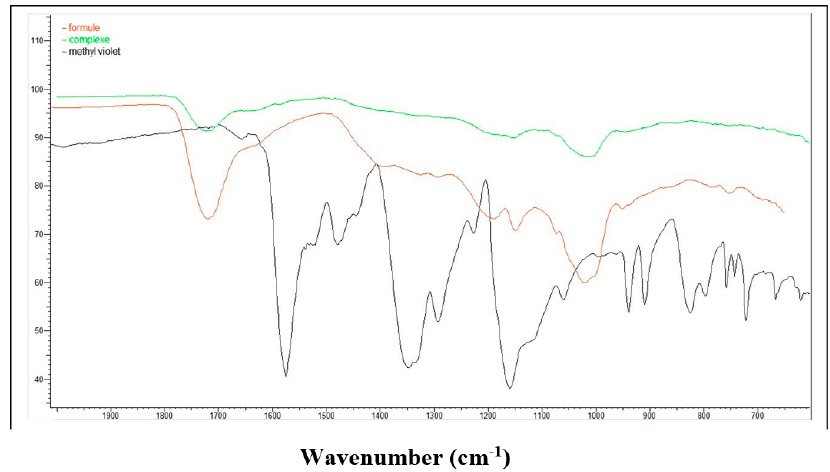
Figure 11. FTIR spectra of methyl violet and β -cyclodexrin polymers after and before adsorption, red ( β -cyclodextrin polymer before adsorption), green ( β -cyclodextrin polymer after adsorption) and black ( methyl violet).